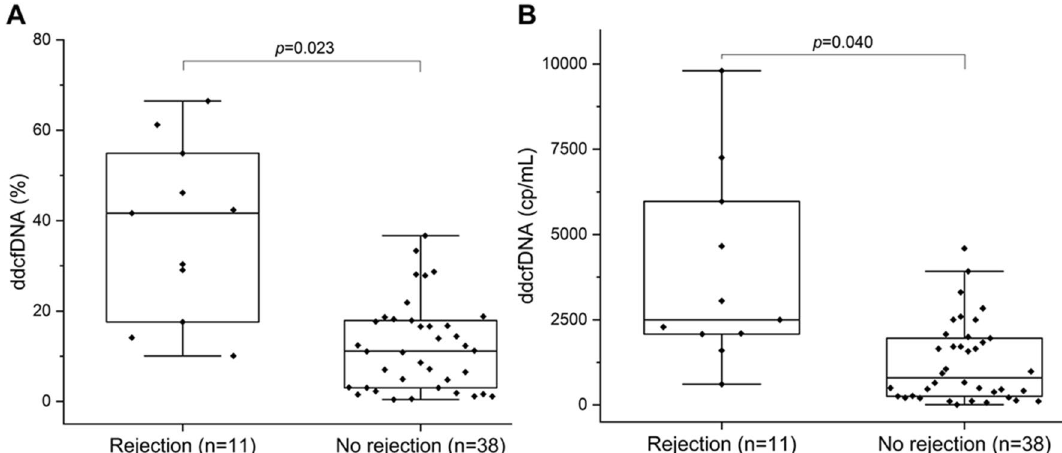
Figure 2. dd-cfDNA levels in rejection and no rejection group. ( A ) Box plots of plasma dd-cfDNA%, horizontal line represents the median; bottom and top of each box represents 25th and 75th percentiles. Dots are individual values. dd-cfDNA fraction (%) in rejection and no rejection group, p values were determined by Mann–Whitney U test. ( B ) dd-cfDNA (cp/mL) in Rejection and no rejection group.